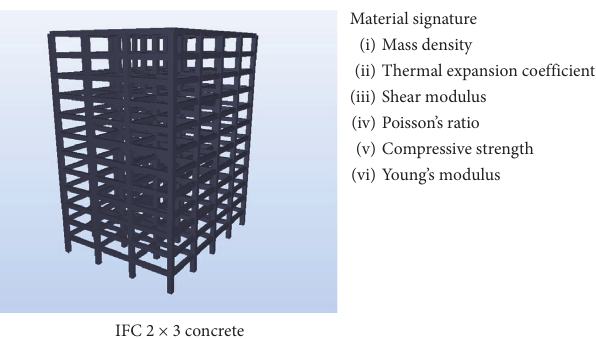
Figure 6: The 12-storey concrete building used in case